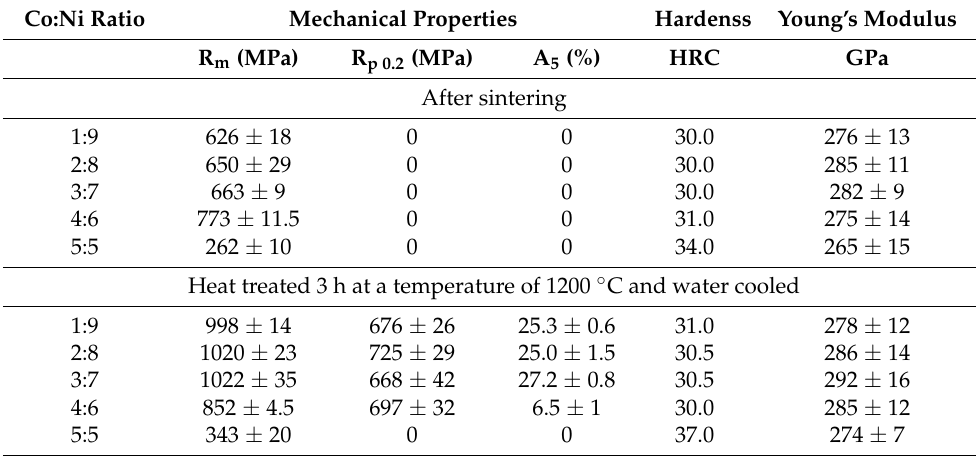
Table 7. The results of mechanical testing.